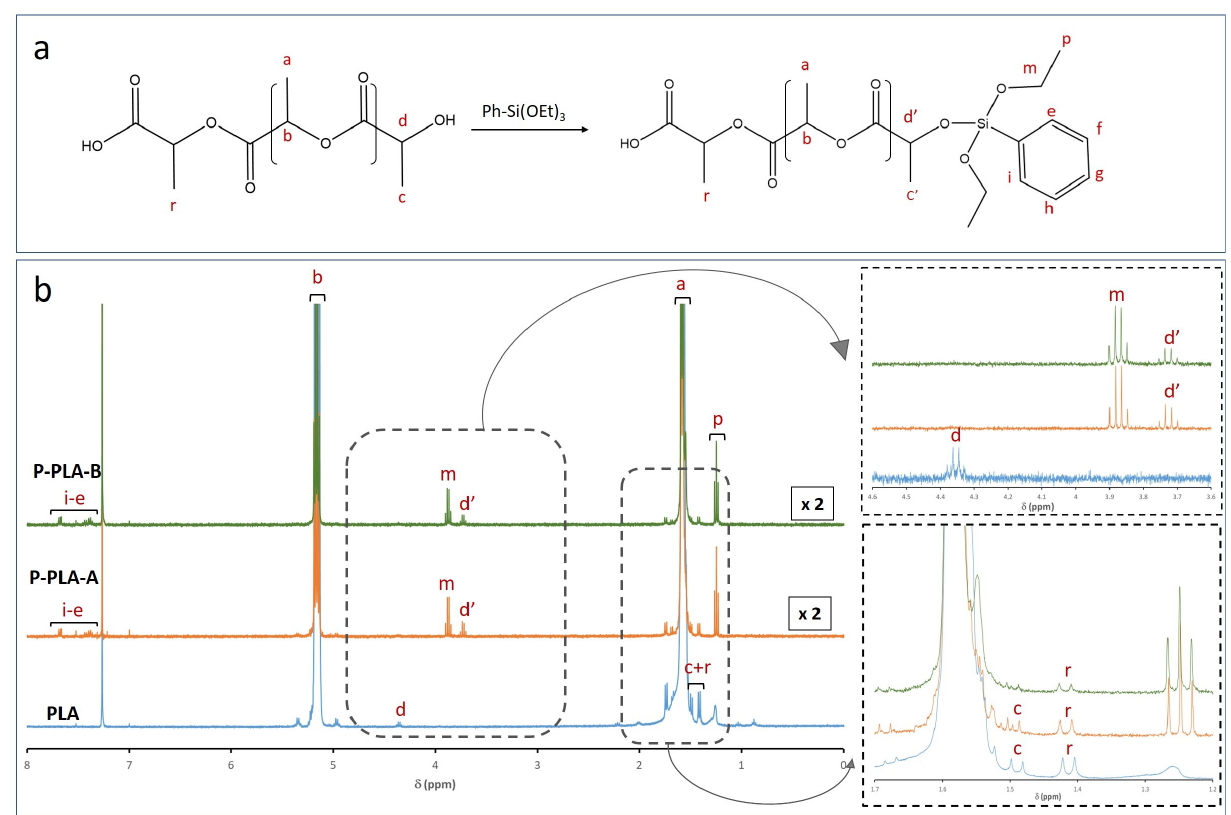
Figure 3. ( a ) Reaction scheme for PLA modification with phenyltriethoxysilane and ( b ) 1 H NMR of neat and functionalized PLA with different phenyltriethoxysilane concentrations: P-PLA-A (1.3 wt%) and P-PLA-B (2.7